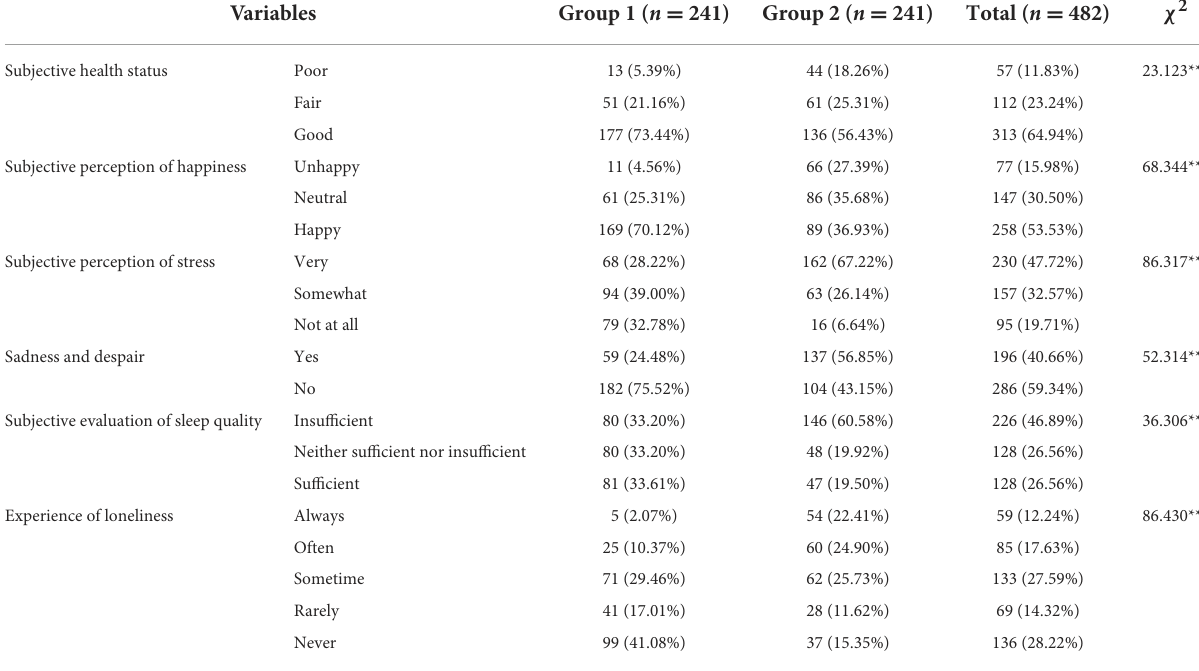
TABLE 2 Cross-tab analysis results on mental health variables by the group.